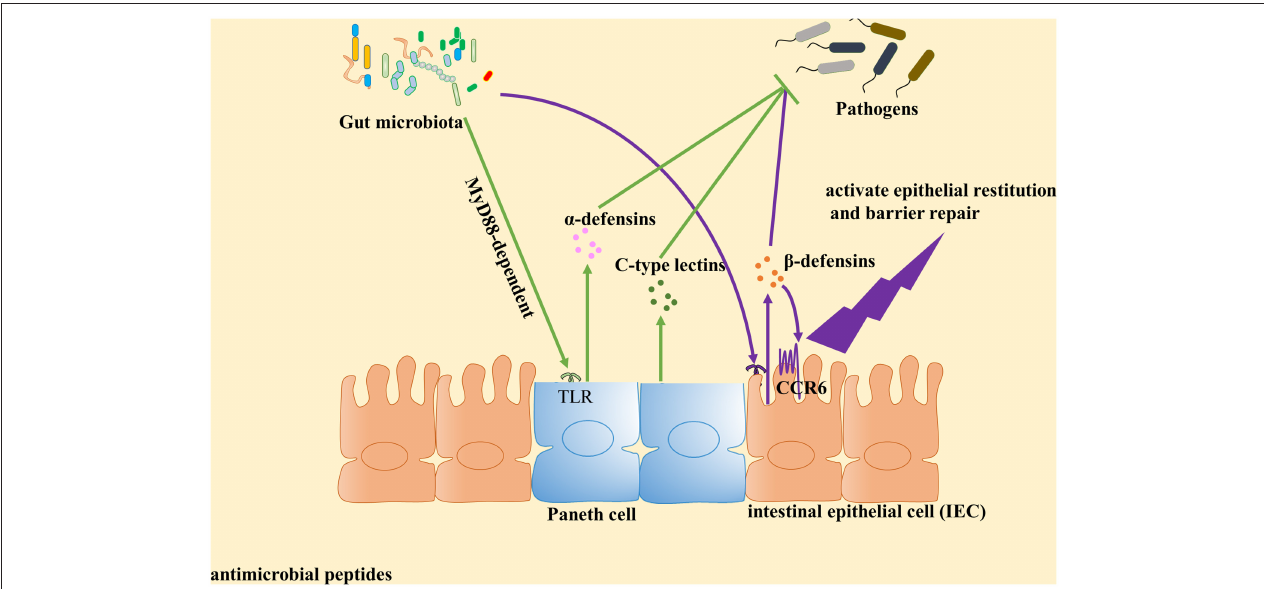
FIGURE 1 | Gut microbiota plays an important role in the induction of antimicrobial peptides expression against pathogens. Antimicrobial peptides are key components of innate immunity to control pathogen growth within the intestine. Accumulated evidence identified that gut microbiota can contribute to the expression of antimicrobial peptides and play a central role in host defense against pathogens. Paneth cells could directly sense gut microbiota through cell-autonomous myeloid differentiation primary response 88 (MyD88)-dependent toll-like receptor (TLR) activation, triggering expression of α -defensins and C-type lectins. With regard to β -defensin, gut microbiota induce β -defensin expression in cell culture mediated by NF- κ B- and MAPK/AP-1-dependent pathways in vitro . Then β -defensin interacts with intestinal epithelial cell (IEC) through CCR6 to activate epithelial restitution and barrier